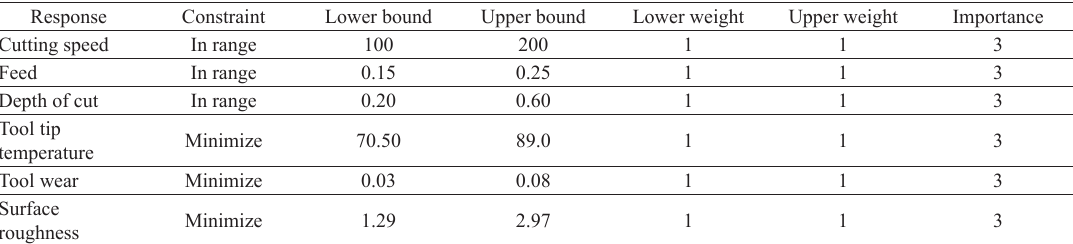
Table 8. Constraints and response variables of multi objective